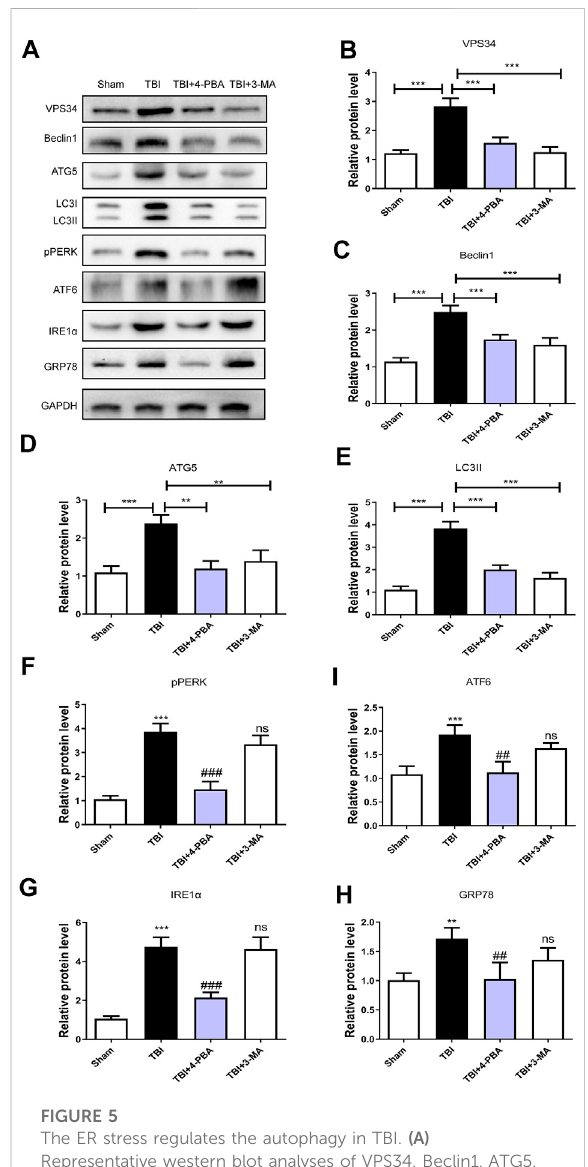
FIGURE 5 The ER stress regulates the autophagy in TBI. (A) Representative western blot analyses of VPS34, Beclin1, ATG5, LC3I/II, pPERK, ATF6, IRE1 α , and GRP78 in the cerebral cortex at 3 days after TBI. (B – H) Quanti fi cation of VPS34, Beclin1, ATG5, LC3II, pPERK, ATF6, IRE1 α and GRP78 in the ipsilateral brain cortex at 3 days after TBI. Data represent the mean ± SD, n = 3, ** p < 0.01 and *** p < 0.001 vs. the indicated group; ** p < 0.01 and *** p < 0.001 vs. the sham group. ## p < 0.01, ### p < 0.001 and ns vs. the TBI